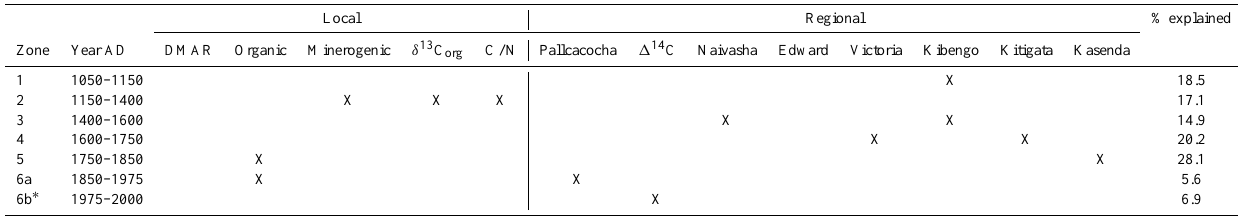
Table 4. Results of the moving window RDA from Lake Kyasanduka. The variance explained is a percentage of the constrained variance. The shaded boxes highlight the most statistically significant driver(s) correlated with a change in the diatom stratigraphy in each of the age